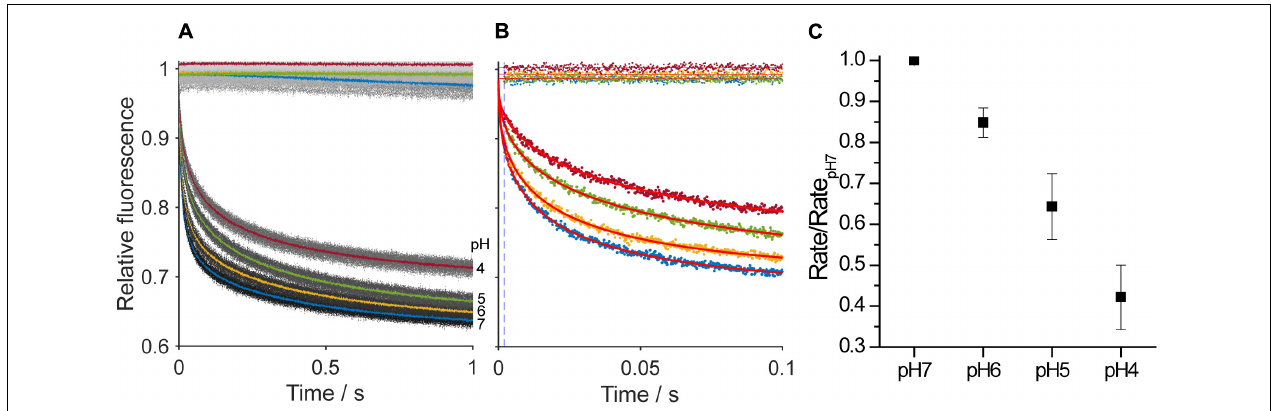
FIGURE 10 | Changes in the time course of fluorescence quench of ANTS-loaded LUVs without gramicidin or that were doped with gramicidin as a function of pH. (A) One second fluorescence quench traces, where the dots denote results from individual repeats ( n > 5) and the heavier traces the average over all repeats in the experiment. (B) One hundred millisecond traces, where the dots denote results from a single repeat and curves are stretched exponential fits to the data. In (A,B) , the top traces were recorded in LUVs without gramicidin and the bottom traces were recorded with gramicidin-doped LUVs. (C) As the pH was decreased the quench rate decreased, which denotes a decrease in the average number of conducting gramicidin channels in the LUV membranes.